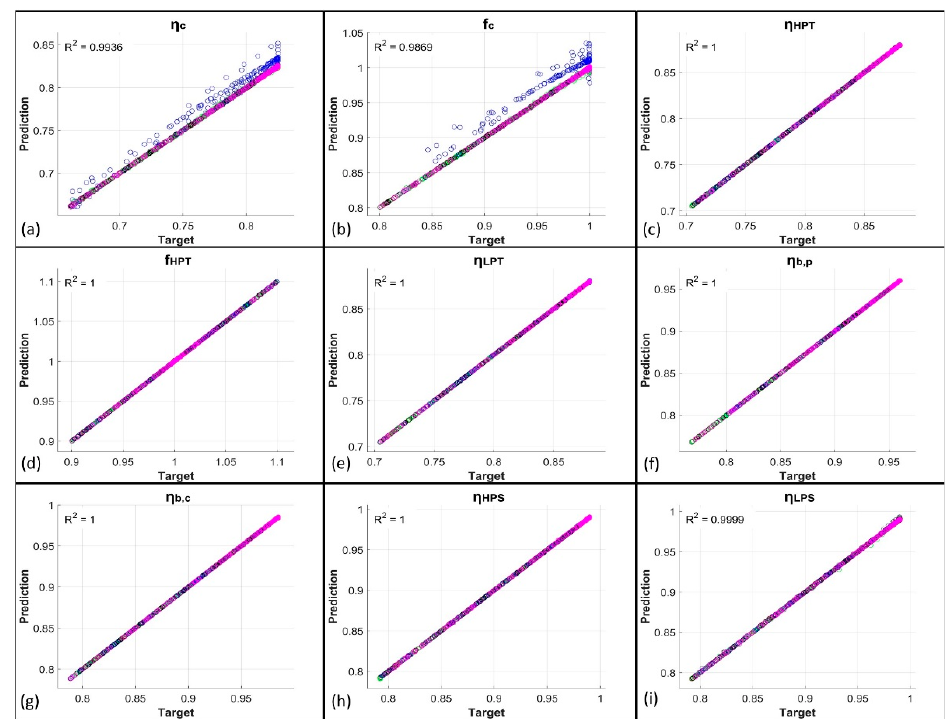
Figure 5. ( a – i ) Comparison between KPCA + FFNN predictions and targets about the PPs related to the first five degradation conditions. Grey: START-A; brown: START-B; green: MAXPOW-A; blue: MAXPOW-B; black: MAXDUR-A; magenta: MAXDUR-B.